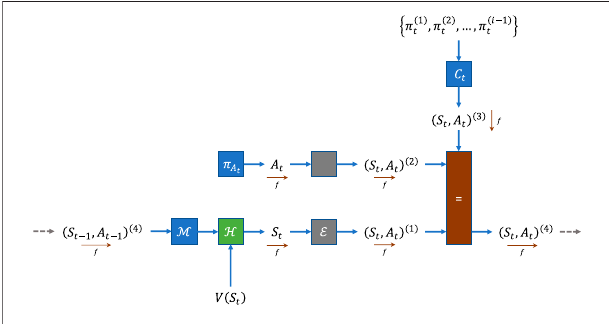
FIGURE 3 | Modi fi ed version of FGrn for the Multi-Agent forward step. Each agent will have its own factorial graph, in which information from previous agents (within the scheduling process) modi fi es the C t variable. The algorithm block H , which analyzes the value function to block the propagation of super fl uous projections is shown in